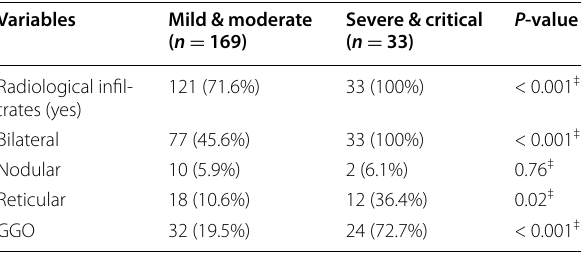
Categorical data represented as number and percentage (%). ‡ chi-square test; P < 0.05 is significant; GGO , ground-glass opacity